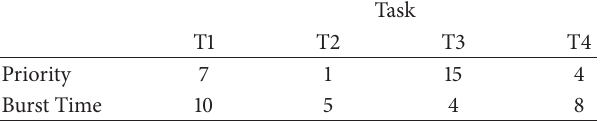
Table 4: Example Task Set 2.